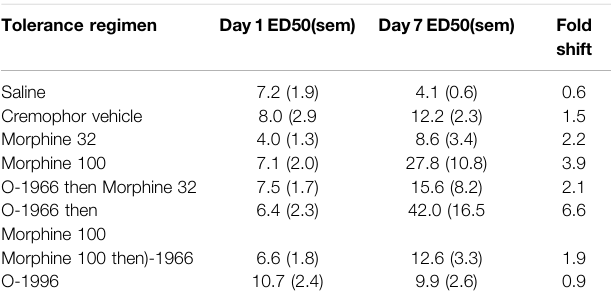
TABLE 2 | Effect of chronic dosing regimens on development of morphine antinociceptive tolerance. Tolerance regimen